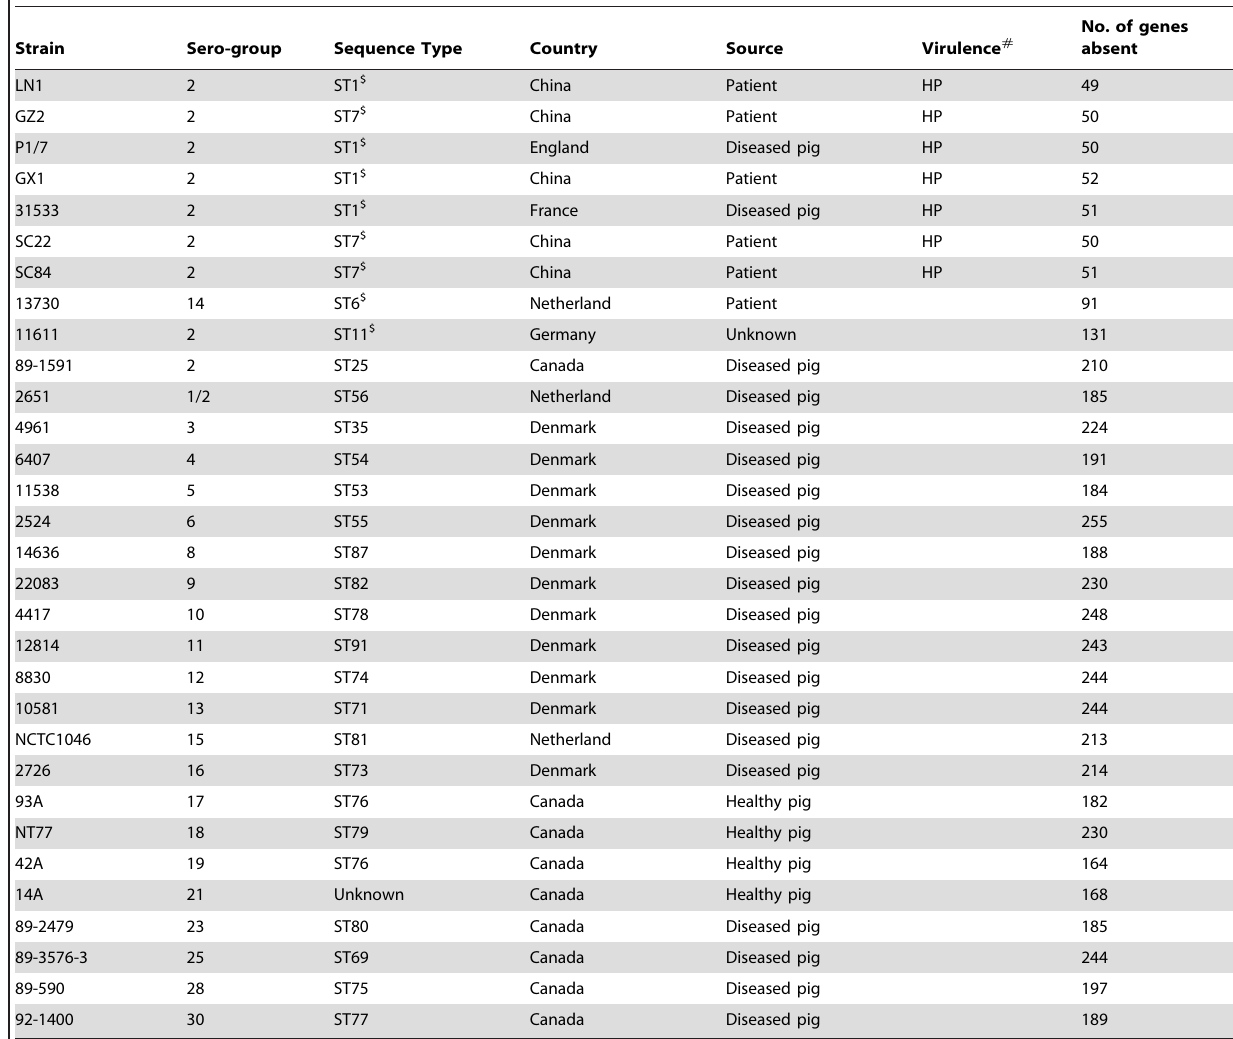
Table 1. Strains used for comparative